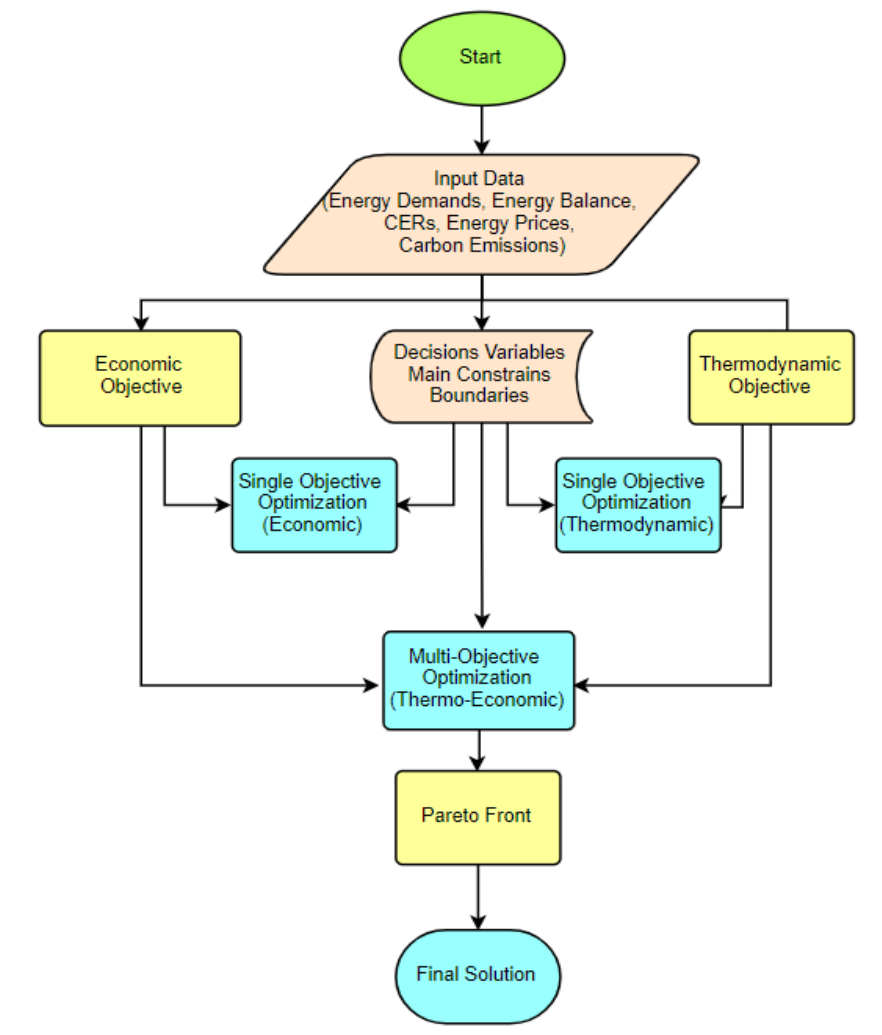
Figure 9. The proposed optimization methodology.